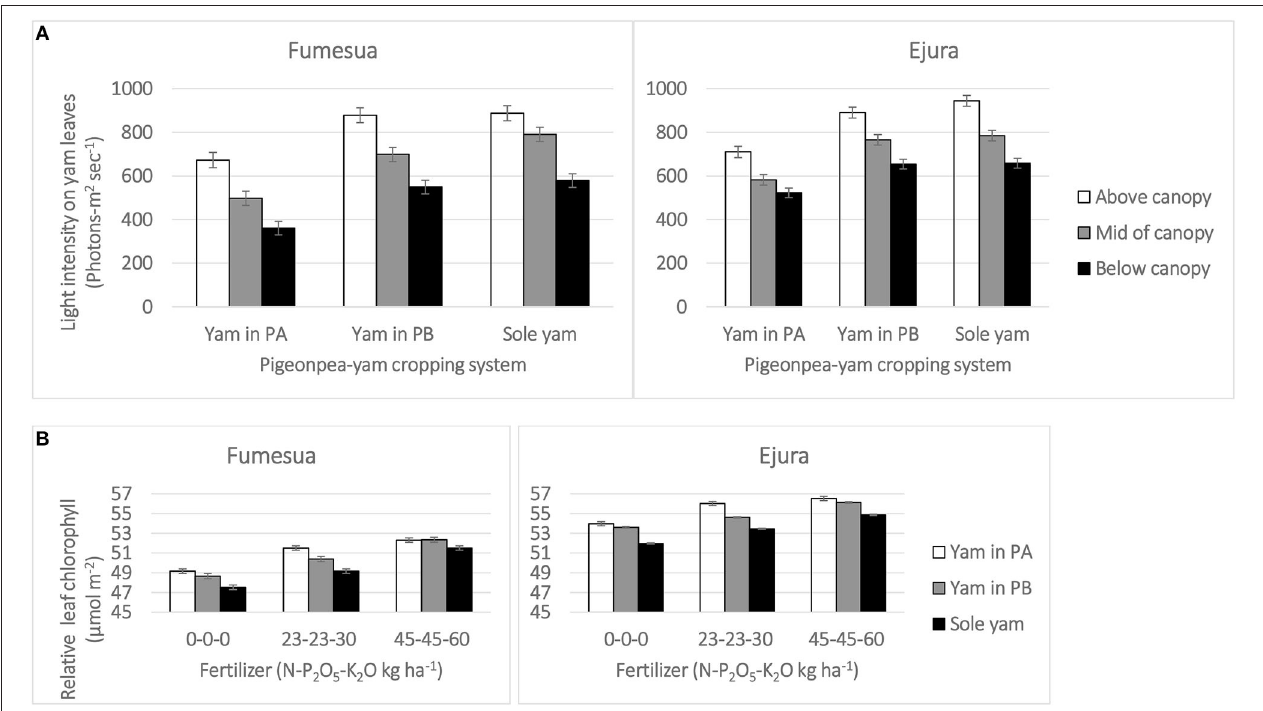
FIGURE 8 | (A) Mean biweekly sunlight photons reaching yam leaves in pigeonpea–yam cropping system. PA, Pigeonpea in alley; PB, Pigeonpea as border. Source (Owusu Danquah 2020). (B) Mean biweekly relative leaf chlorophyll content of yams in pigeonpea–yam cropping system. PA, pigeonpea in alley; PB, pigeonpea as border. Source: Owusu Danquah (2020).